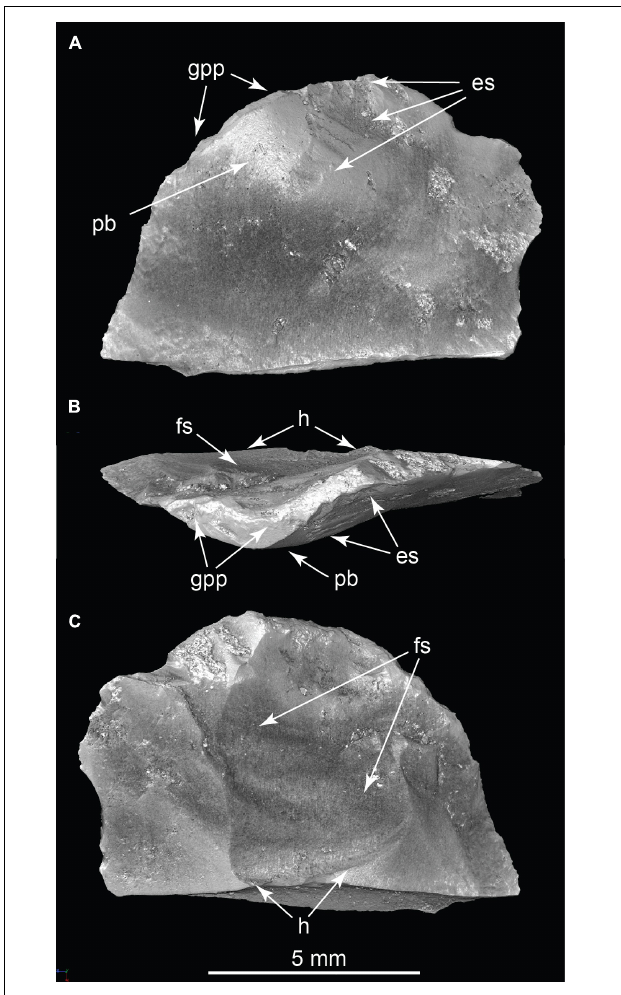
FIGURE 13 | Chert microflake in three views. (A) Internal aspect; (B) Striking platform; (C) External aspect. Es, eraillure scar on bulb of percussion; Fs, secondary flake scar showing ripple marks; H, secondary flake scar hinge; Pb, bulb of percussion; Gpp, ground percussion platform. (TMM 47004-5.1; Supplementary Video 13